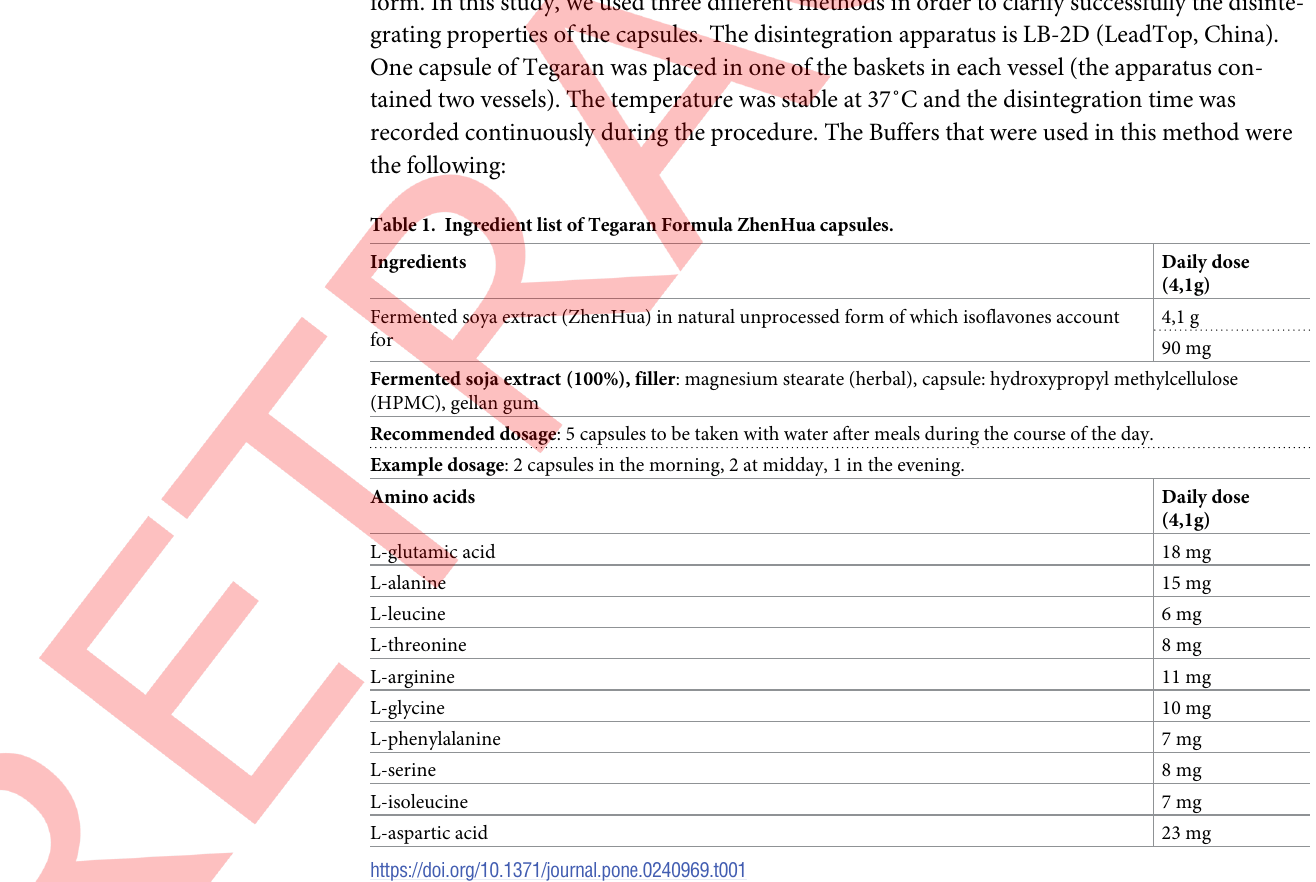
Table 1. Ingredient list of Tegaran Formula ZhenHua